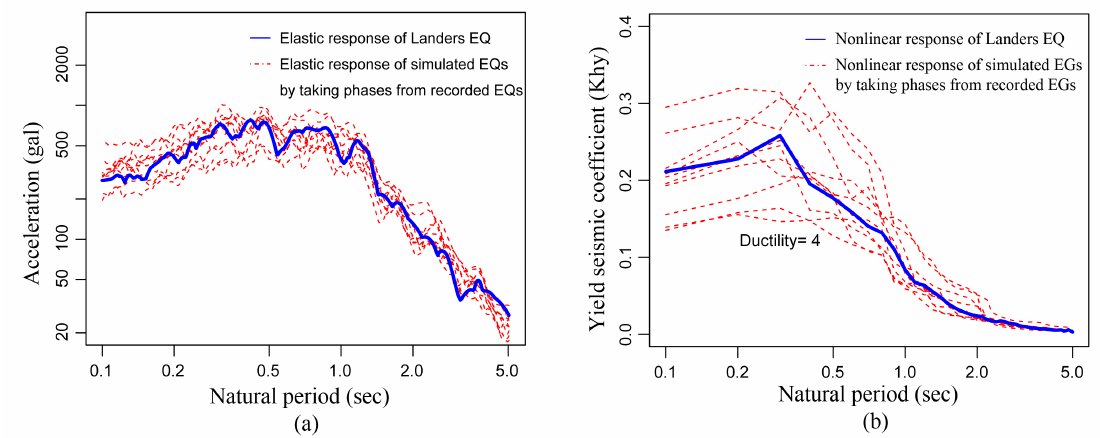
Figure 5. ( a ) Elastic and ( b ) Inelastic response spectra. Full blue line is the result obtained by using original time history and dots red lines are the results obtained by simulated time histories according to the different observed ground motions